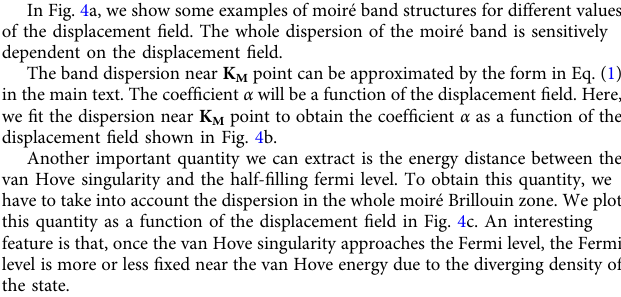
ffiffiffiffiffiffiffiffi p ρ = K ¼ 1, τ = 10. In the diffusive case, we use D = 1, τ =